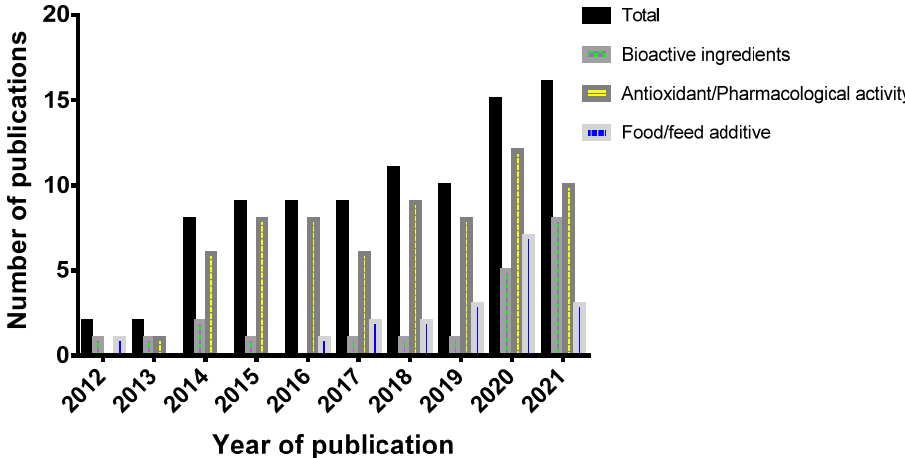
Figure 2. Growing number of publications on the nutraceutical potential of sumac from 2012 to 2021 (https://pubmed.ncbi.nlm.nih.gov/?term=rhus+coriaria; accessed on 25 June 2022).